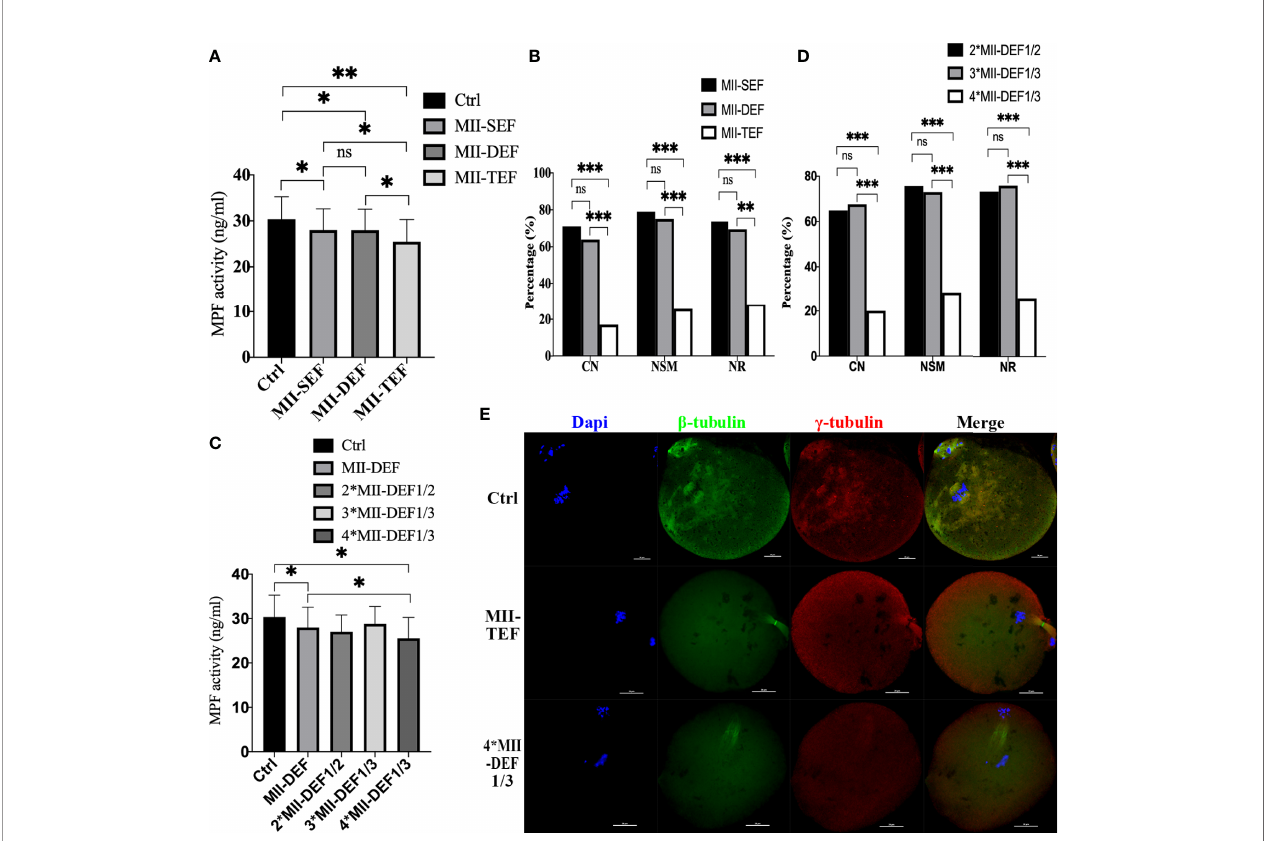
FIGURE 4 | Electrofusion stimulation also caused premature activation in MII oocytes, which was signi fi cantly increased in both MII-TEF and 4*MII-DEF1/3, and both had a negative effect on chromosome arrangement and spindle assembly. (A) MPF activity. MII-SEF, MII-DEF and MII-TEF respectively represented the single electrofusion group, the double electrofusion group, the triple electrofusion group in MII oocytes. Data is expressed as mean ± standard deviation. *P<0.05, **P<0.01, ns, P>0.05. Value, the MPF activity per 100 oocytes (ng/ml). (B) CN, NSM, and NR in MII-TEF were signi fi cantly decreased. ***P<0.001, **P<0.01, ns, P>0.05. MPF activity in 4*MII-DEF1/3 was decreased in (C) , as well as CN, NSM, and NR in (D) . *P<0.05, ***P<0.001, ns P>0.05. (E) Representative images in Ctrl were normal in terms of chromosomes, spindle morphology, and g -tubulin location. In MII-TEF and 4*MII-DEF1/3, the chromosomes were separated in advance, spindle morphology was abnormal, and the g -tubulin localization was disordered. Scale bar, 20 m